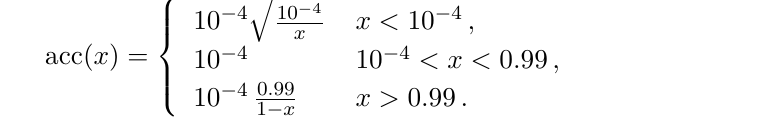
Figure 14 . Momentum fraction carried by all stable SM final states considered in this work for two example decays, χ → ν ¯ ν (left) and χ → b ¯ b (right). In both cases we show how the fractions e e evolve as a function of DM mass. In the legend, particle labels are a proxy for the contribution of both particles and antiparticles, so ν labels the momentum fraction carried by both ν µ termine the FFs d ( x ) as ln( x ) spaced histograms, and then perform the convolution using the approach in appendix